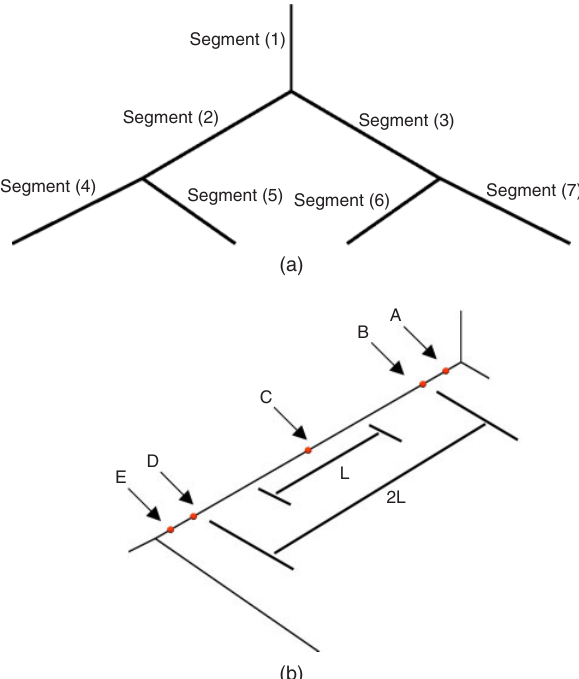
Figure 1 (a) Coronary artery network model—labelled in the figure are the numbers of the network vessel segments. The lengths of the segment are: (1) is 20 mm, (2) and (3) are 40 mm, (4) and (7) are 34 mm, (5) and (6) are 26.5 mm. (b) Close-up of segment 2 where the stent was placed— L is the length of the stent in place (15 mm in this study), 2 L denotes the region where the stent affects the material properties of the vessel, A–E are points along the vessel segment at which results are presented later in the